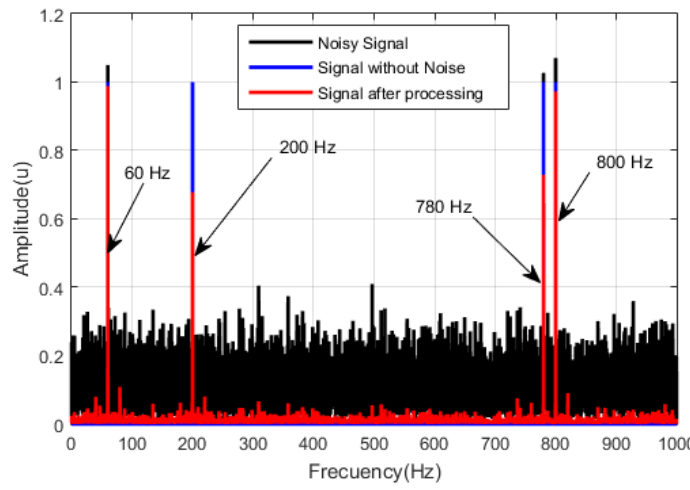
Figure 7. The spectrum of the original signal (blue), the spectrum of the noisy signal (black), and the spectrum obtained after applying our algorithm for noise reduction without additional information of the input signal (red); 64,000 processed samples.